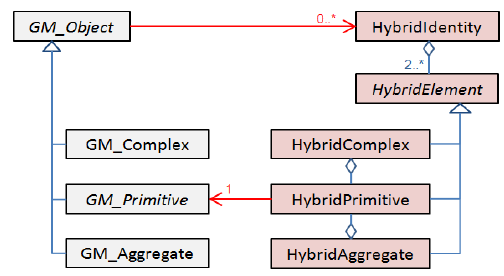
Figure 4. Data model for hybrid identities.